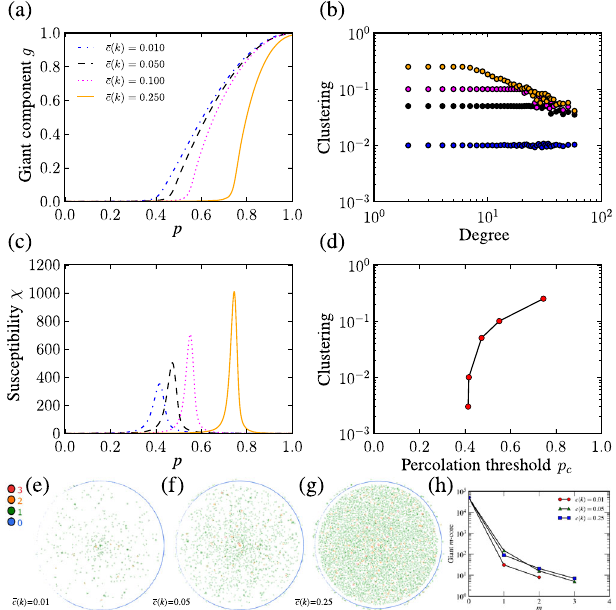
FIG. 6. Top panels: Bond percolation simulations for networks of 10000 nodes with a power-law degree distribution with γ ¼ 3 . 5 and different levels of clustering. (a) Relative size of the largest connected component g as a function of the bond occupation probability p . (b) Degree-dependent clustering co- efficient ¯ c ð k Þ . (c) Susceptibility χ as a function of bond occupation probability p . (d) Percolation threshold ( p function of the level of clustering. Bottom panels: (e-g) m -core decomposition of three different networks of 50000 nodes, γ ¼ 3 . 5 , and different levels of clustering, ¯ c ð k Þ ¼ 0 . 01 , 0.10, 0.25. (h) Size of the largest connected component of the m -core as a function of m .